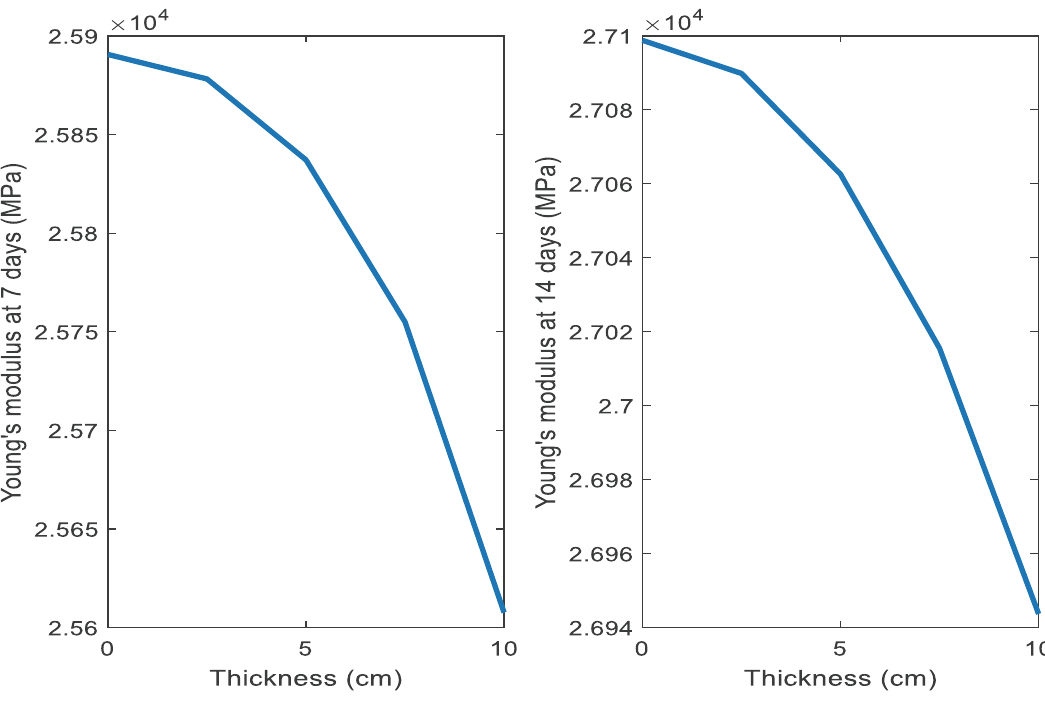
Figure 11: Young modulus variation in the thickness at di ff erent age.